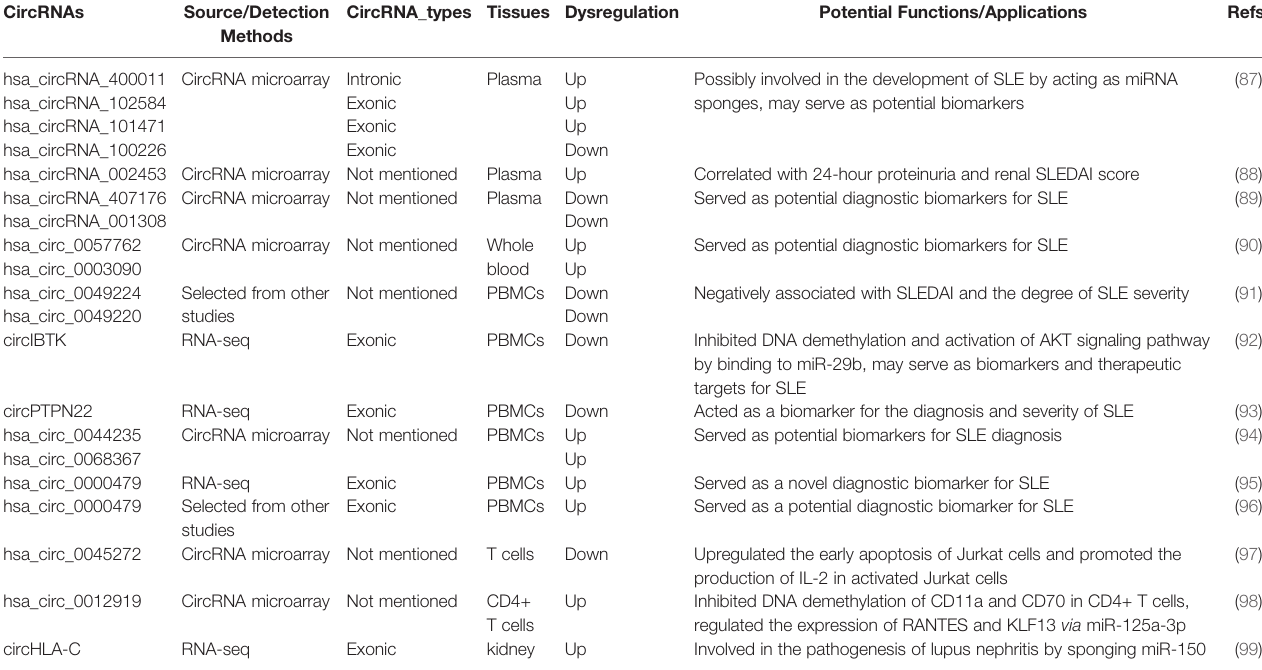
TABLE 1 | Summary of circRNAs implicated in SLE.